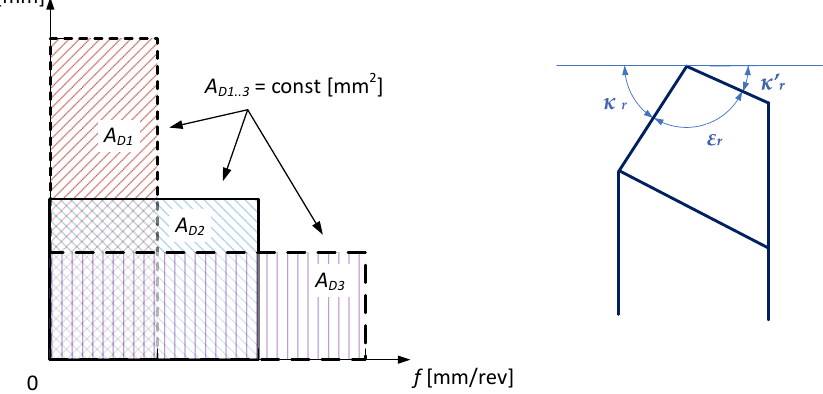
Figure 1. A simplified diagram of the cross-section shapes of the cutting layer while maintaining a constant cross-section for turning with entering angle Ҝ R = 90°.